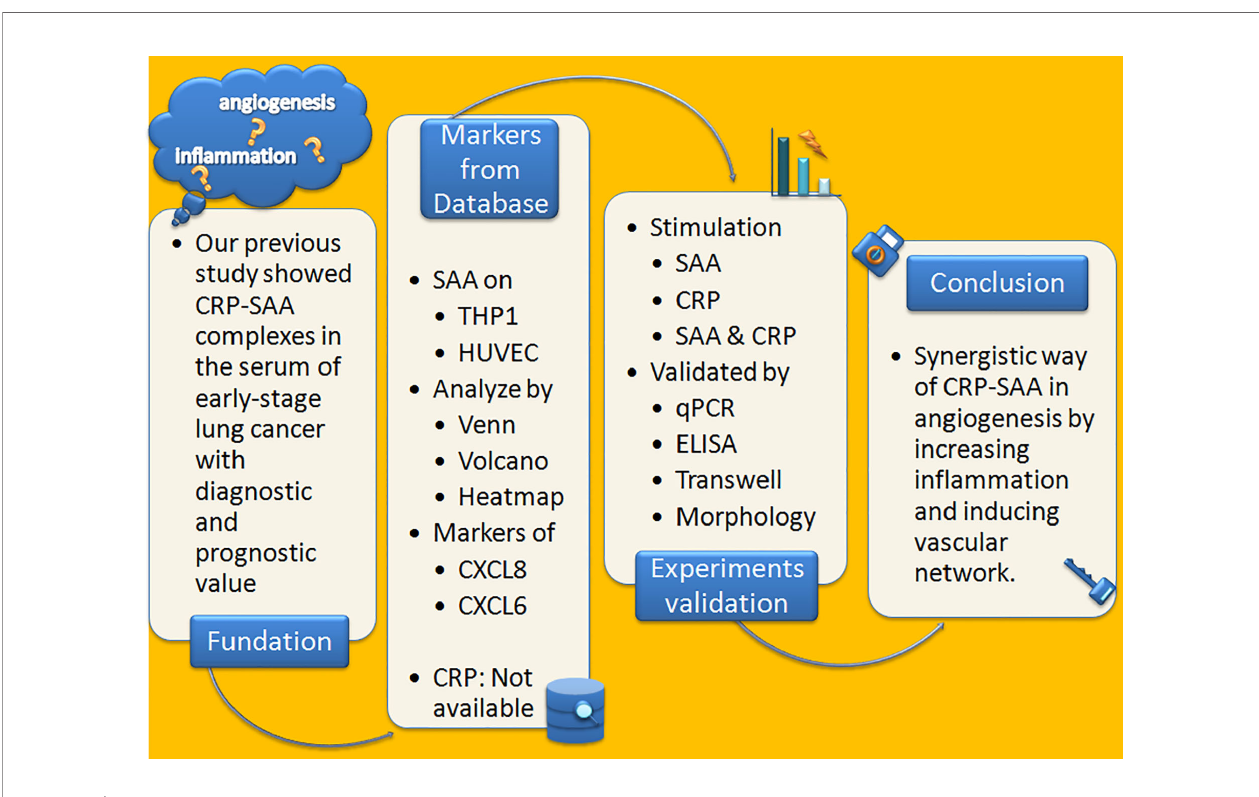
FIGURE 4 | A fl owchart of the project